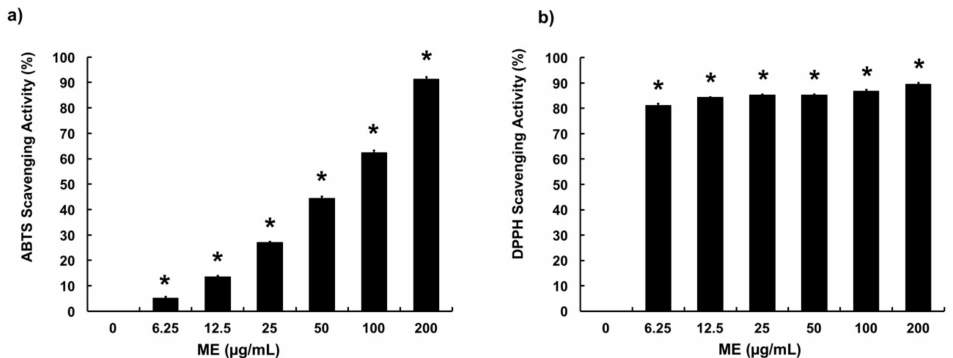
Figure 1. Radical scavenging activities of moringa extract (ME). ( a ) ABTS and ( b ) DPPH radical scavenging assays were performed to determine antioxidant activity of ME at concentrations of 0–200 µ g / mL. Values represent means ± SEM ( n = 5). *, significant di ff erence vs. control ( p < 0.05).